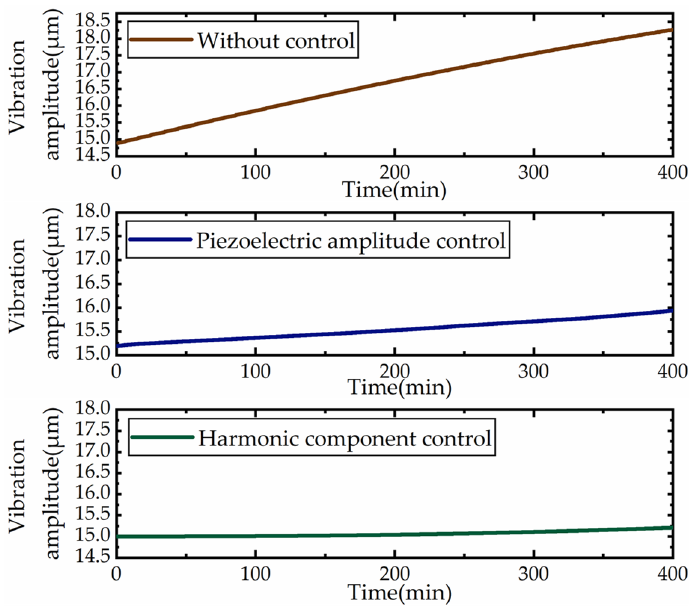
Figure 7. Control effect of the variable temperature condition.